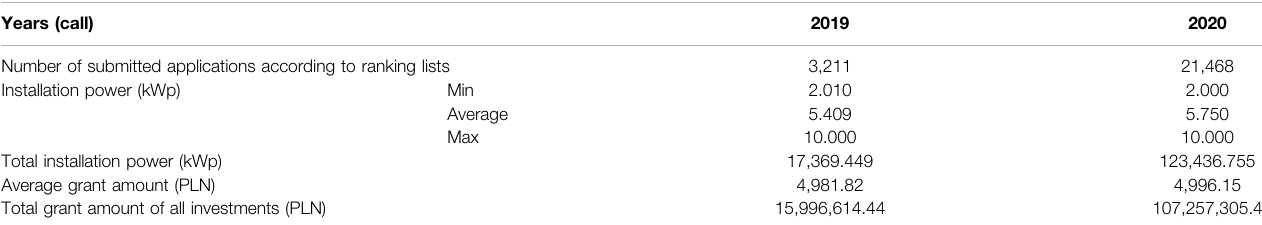
TABLE 4 | Volume of subsidies and achieved installation capacity in the government program called My Electricity in the Ma ł opolska Voivodship 5 . Years